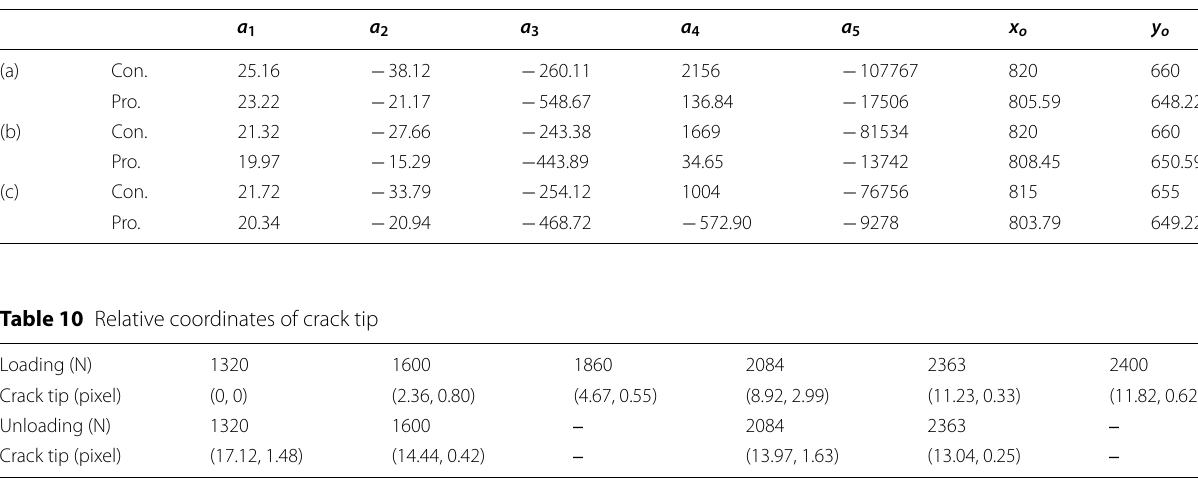
Table 9 Williams equation parameters and crack tip coordinates